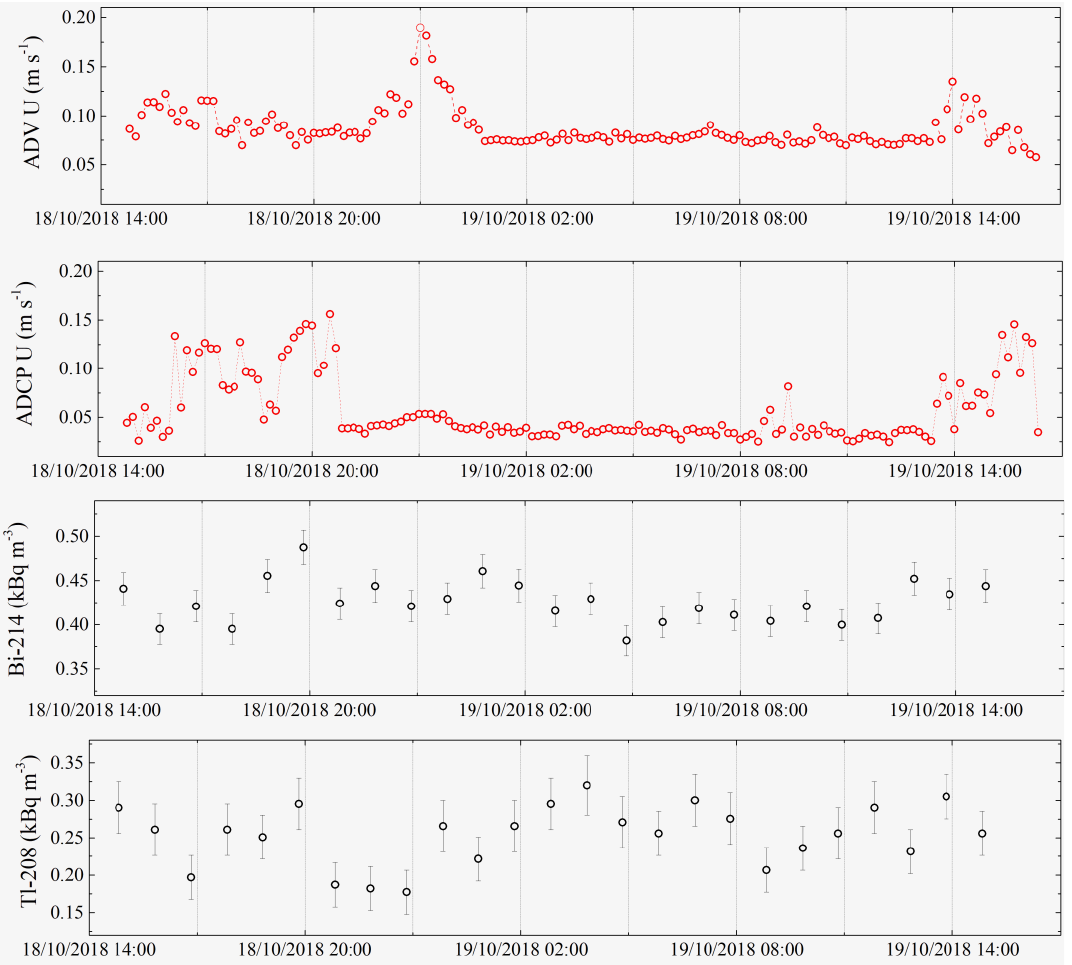
Figure 5. Overlapped time series of current velocity by the two instruments and activity concentration of radon progeny ( 214 Bi) and thoron progeny ( 208 Tl).